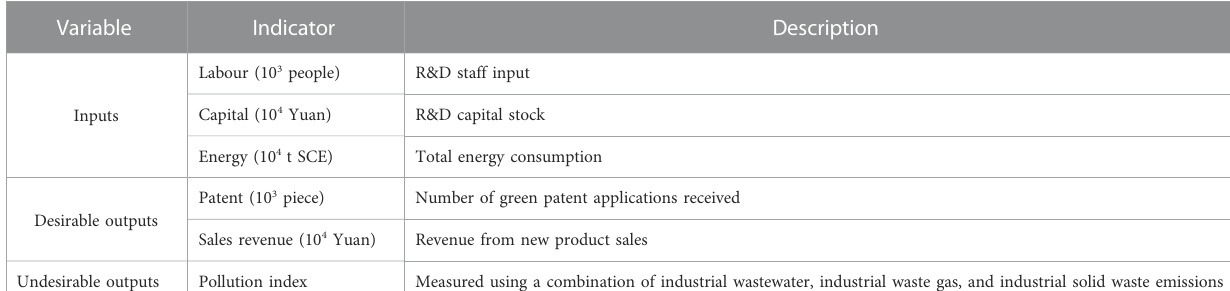
TABLE 1 Input – output indicator system of energy eco-ef fi